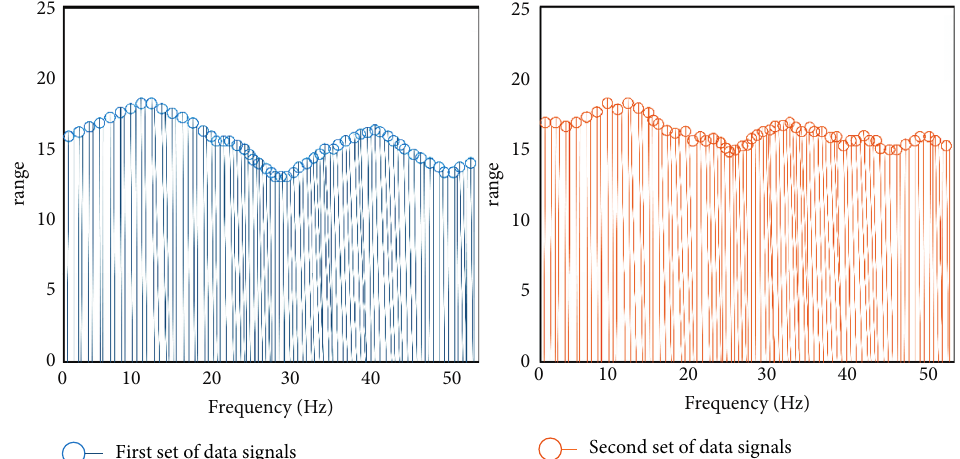
Figure 8: Frequency distribution diagram of two groups of data signals.